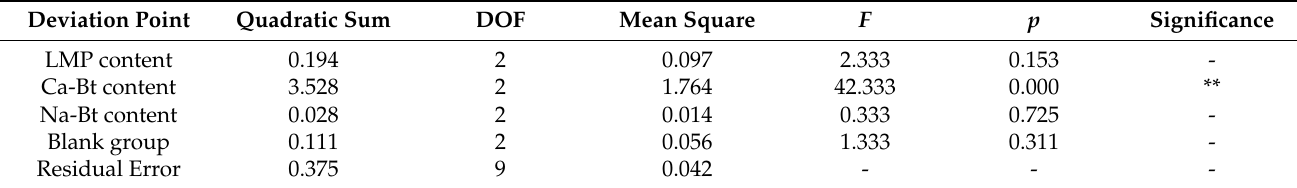
Table 3. Analysis of variance for the critical pH